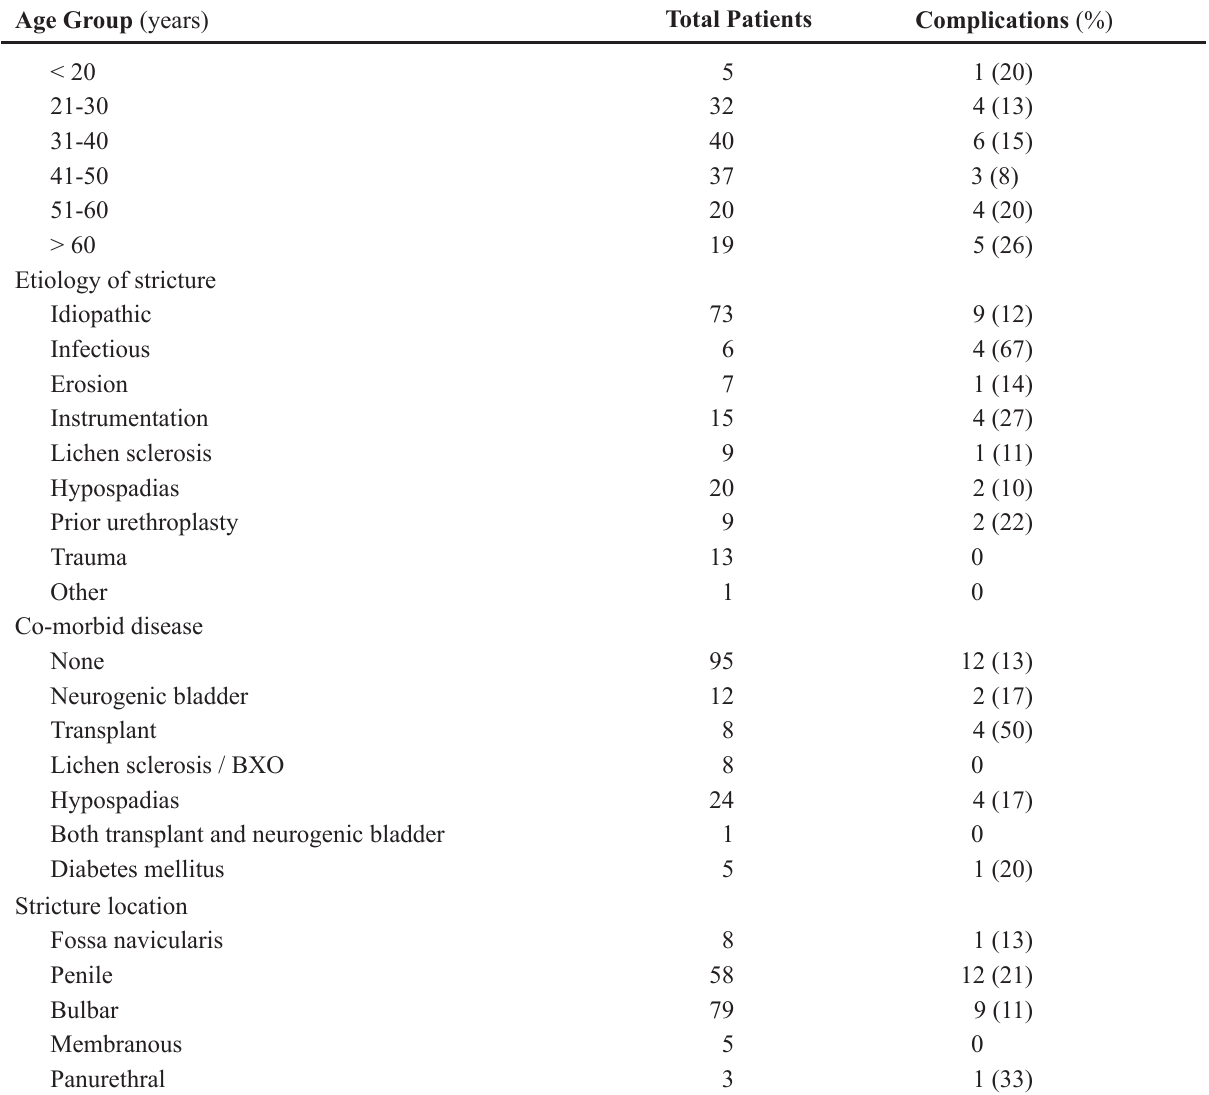
Table 4 – Complication rate by age, etiology of stricture, co-morbid disease, and stricture location. Age Group